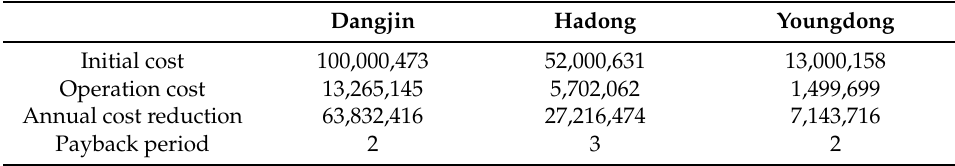
Table 11. Cost analysis (Thousand-won).